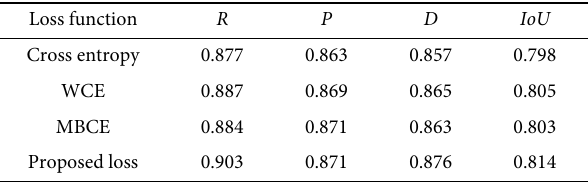
Table 3 Comparison results of the proposed loss function with